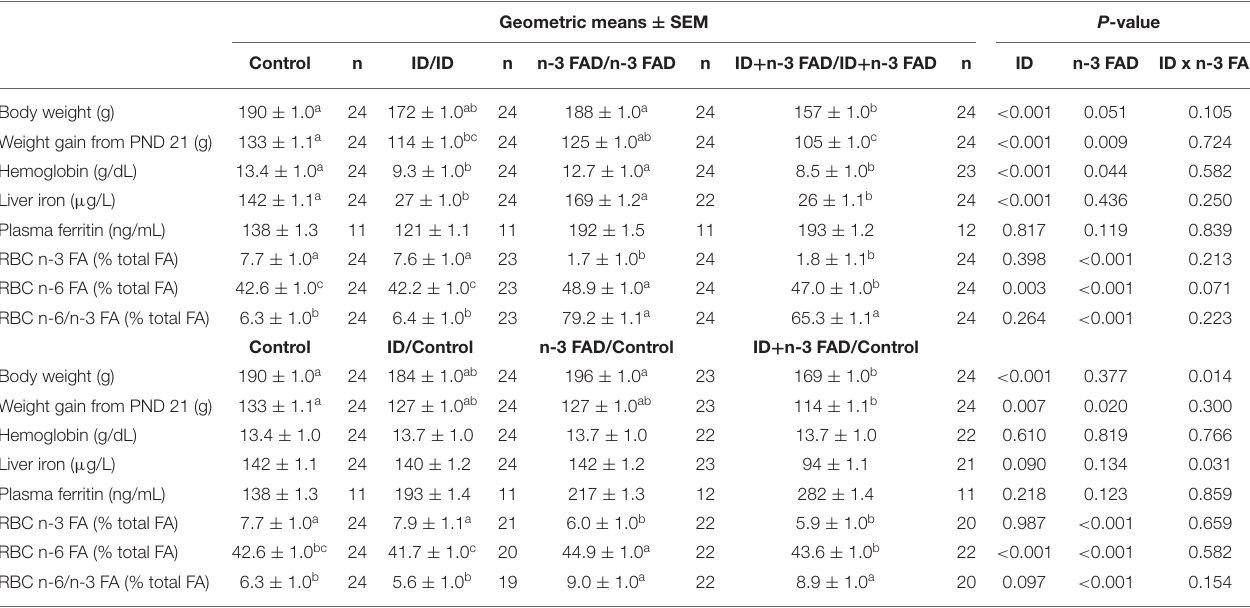
TABLE 1 | Offspring body weight, iron, and n and omega-3 fatty acid status at post-natal day